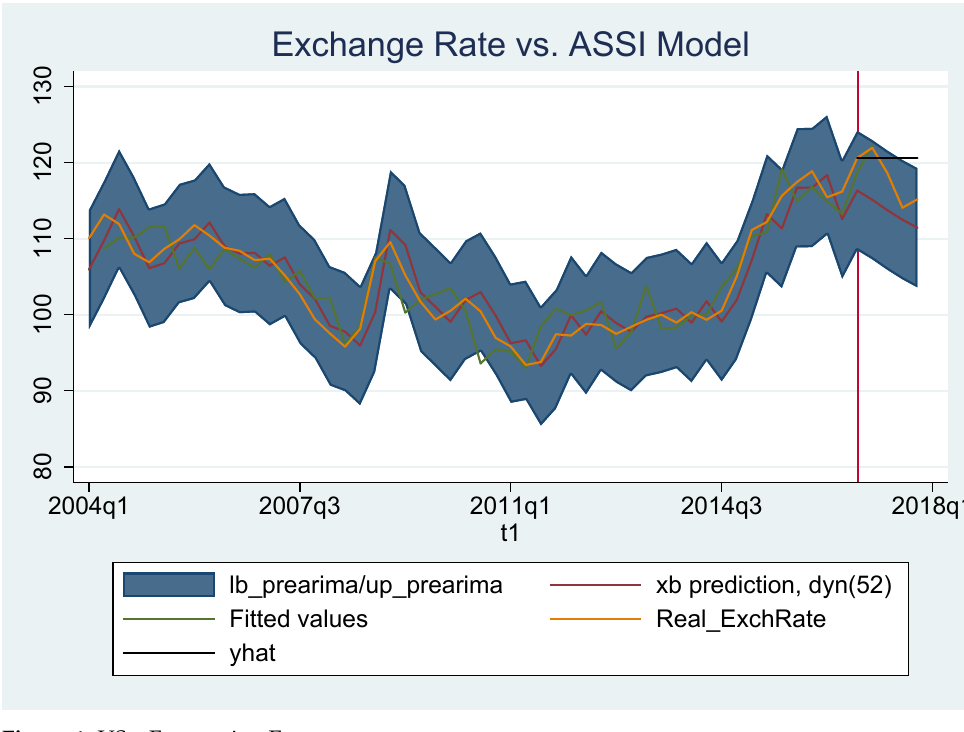
Figure 1. US—Forecasting Errors.